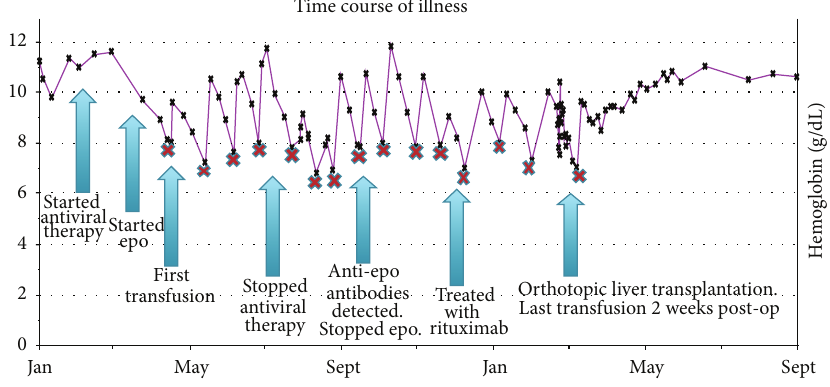
Figure 2: A graph of fluctuating hemoglobin levels throughout time course of illness. The patient experienced a drop in hemoglobin shortly after starting antiviral therapy. Despite dose reduction and discontinuation of antivirals, he was transfusion dependent. Packed red cell transfusions are marked by the red X. After orthotopic liver transplantation, hemoglobin levels increased without any further transfusion requirements. He has continued to have sustaining hemoglobin levels >